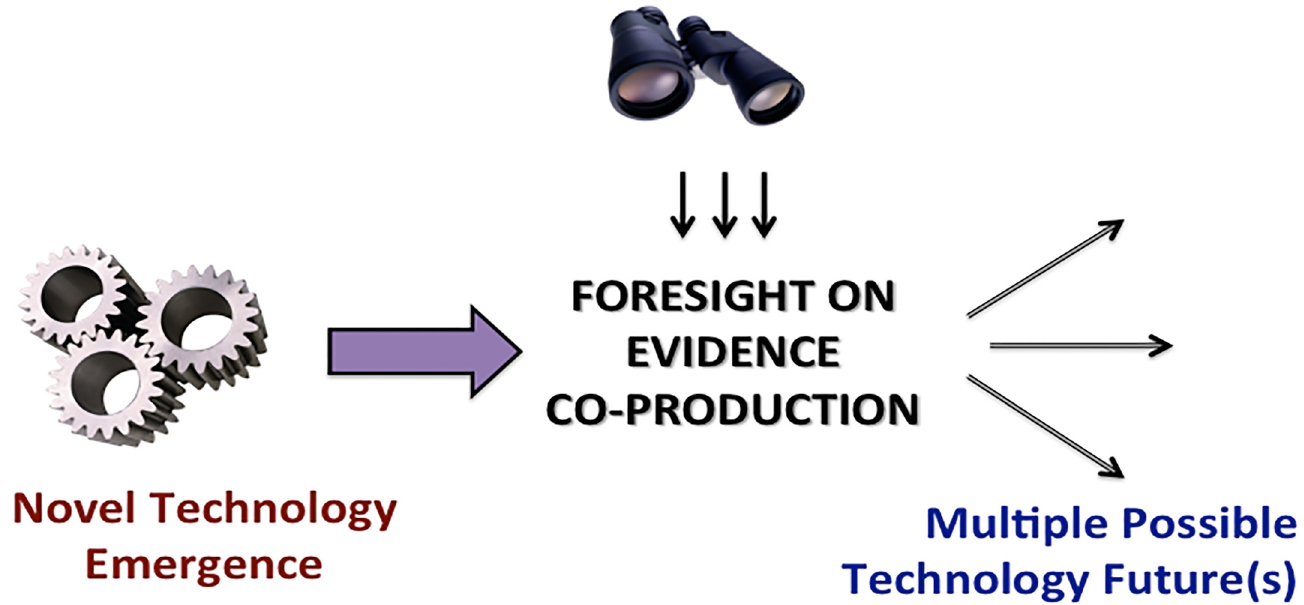
Fig 1. Evidence as the focus of foresight research. Situated conceptually between novel technology emergence and adoption future(s) , examination of the attitudes towards co-production of technology-related evidence by the innovation ecosystem constituents (e.g., scientists and policymakers) can help build strategic foresight on the innovation